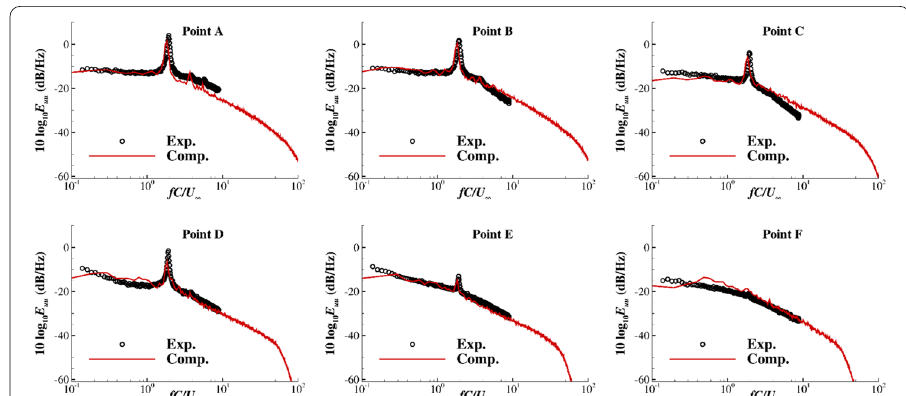
Fig. 15 Velocity spectra at several sampling points